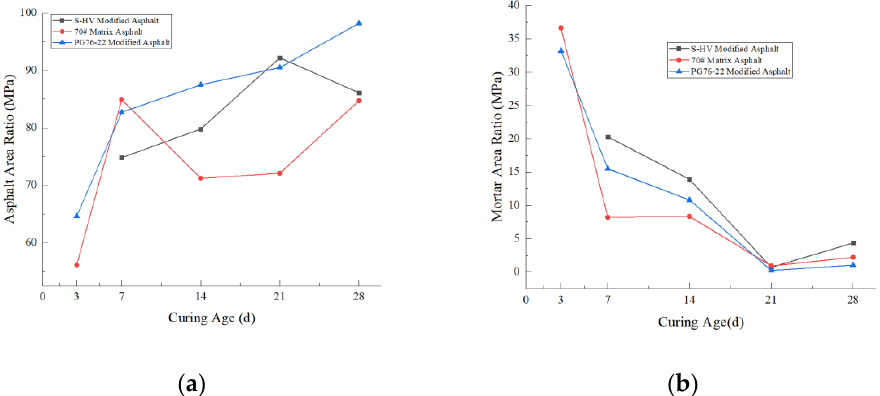
Figure 11. Changes in area ratio with curing age. ( a ) Changes in asphalt area with curing age, ( b ) Changes in mortar area with curing age.